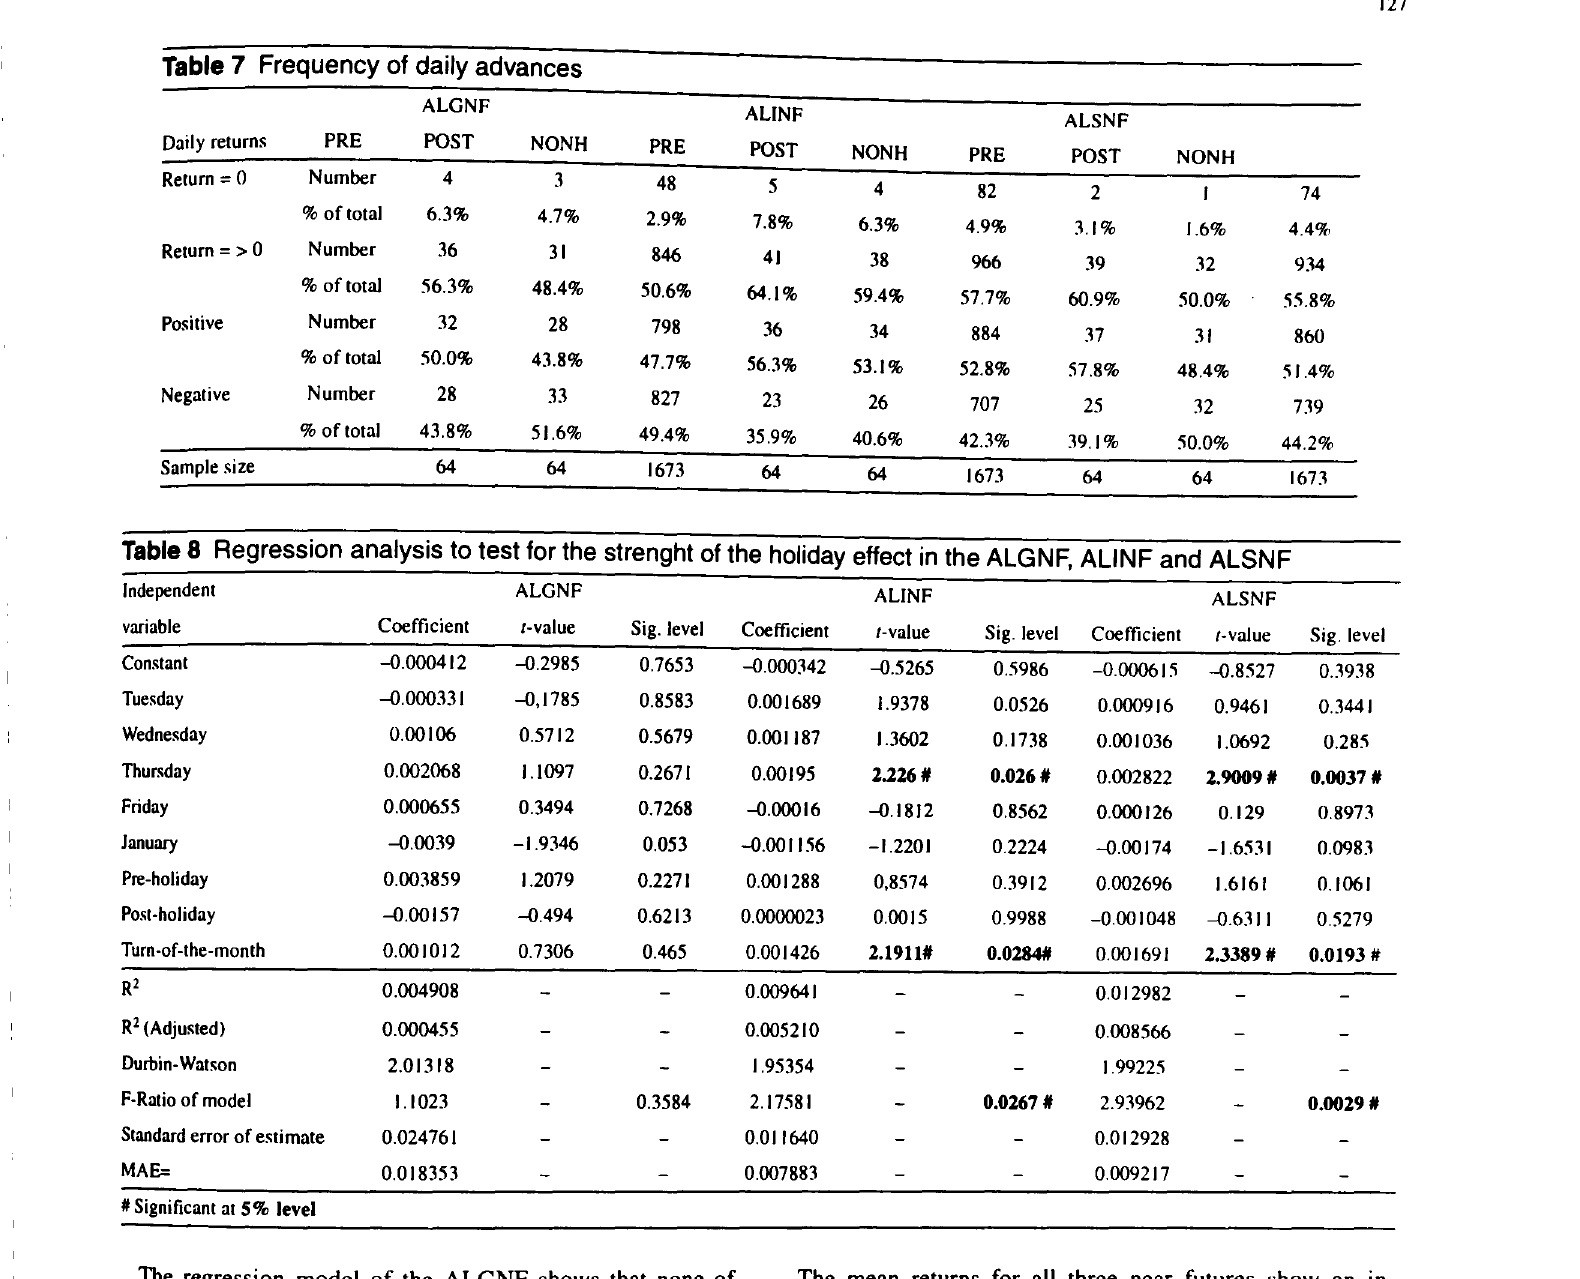
Table 7 Frequency of daily advances